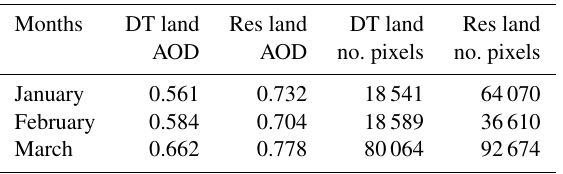
Table 4. Domain-averaged (25 to 40 ◦ N and 105 to 120 ◦ E) monthly mean MODIS-derived AOD with QA = 3 at 0.55µm over land for the operational (DT) and research (Res) algorithms and the number of valid retrievals in